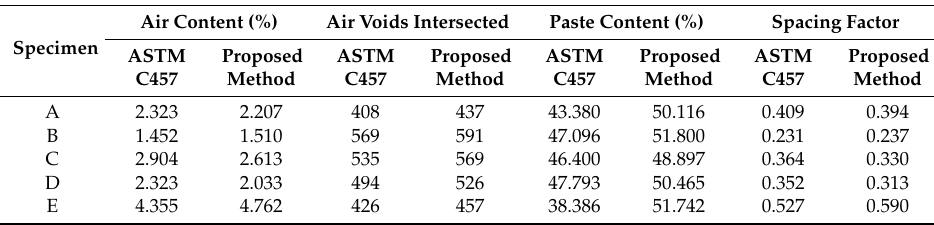
Table 6. Comparison of values obtained on five specimens by using a stereoscopic microscope (ASTM C457) and the method proposed in this study.